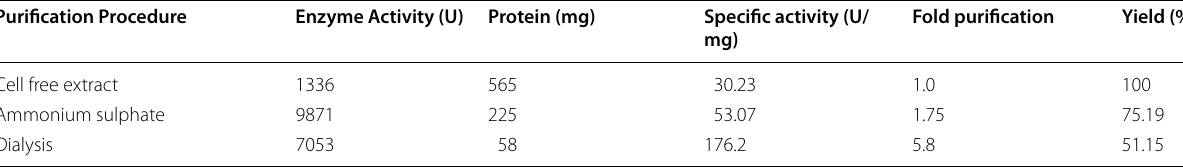
Table 2 Purification steps of l -glutaminase produced by Bacillus sp. DV2-37